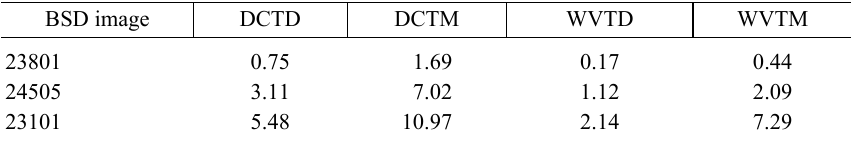
Table 1. DCT and DWT values for a small, medium, and high number of details in images BSD